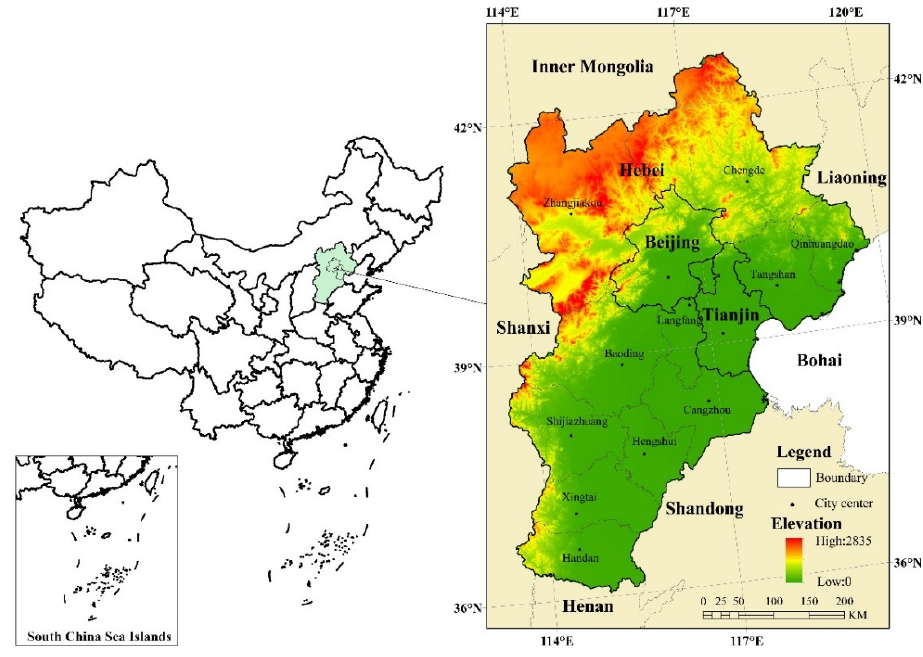
Figure 2. Location of the study area.